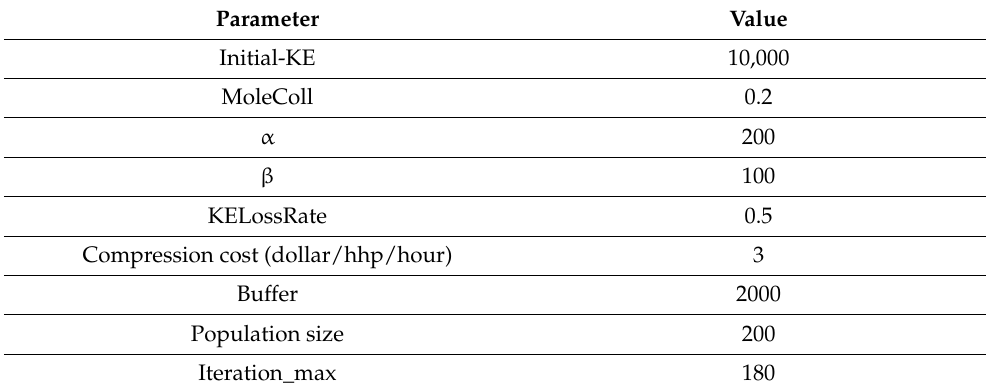
Table 3. Simulation